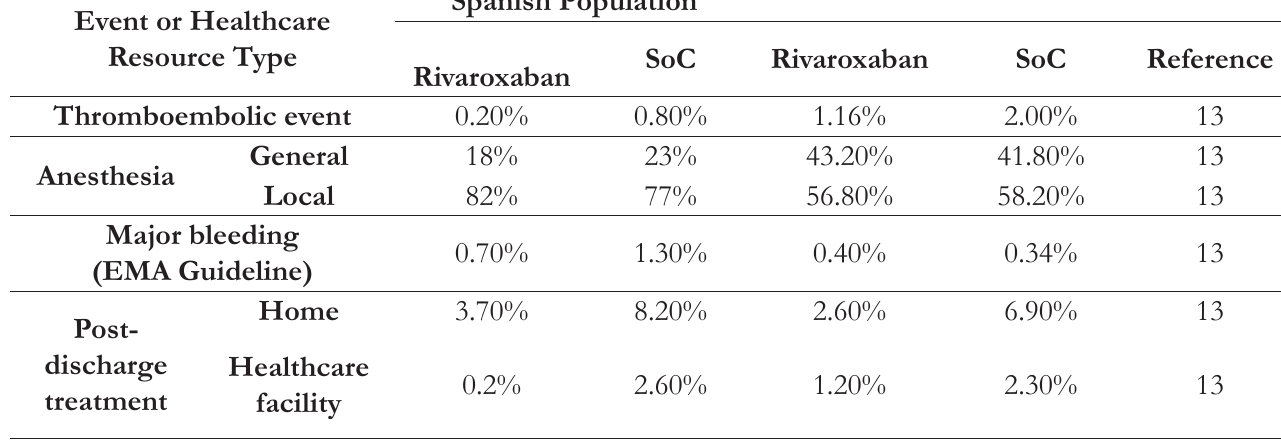
Table 1. Rate of Events and Use of Health Care Resources associated with Rivaroxaban and Standard of Care (i.e. enoxaparin) in the Spanish and Multinational Cohort of the XAMOS Study